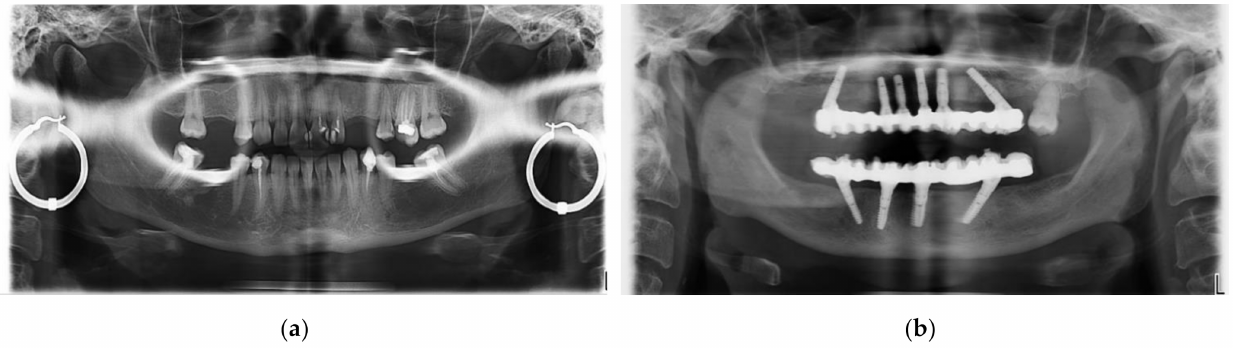
Figure 17. Imaging artefacts on panoramic radiographs: ( a ) in the case of a woman who cannot remove her earrings and ( b ) for a patient with ten implants and teeth